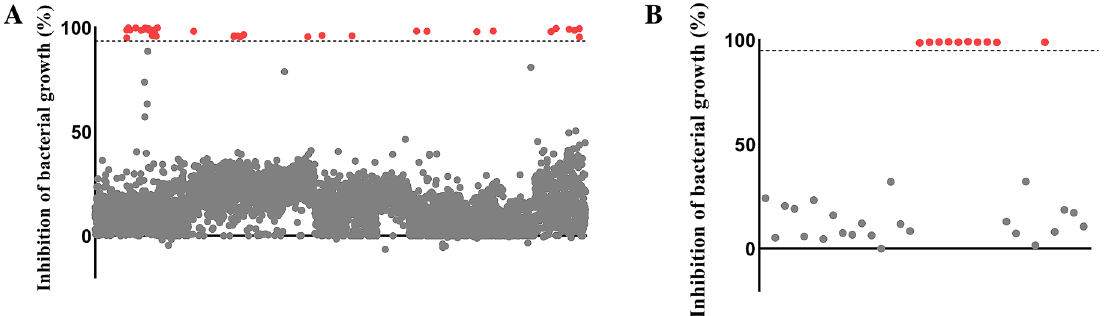
Figure 1. High-through screening (HTS) of the AnalytiCon NATx library identifies novel lead scaffolds. ( A ) Results from HTS of 5000 natural product-like compounds from the AnalytiCon NATx library. Compounds were screened at a concentration of 3 µM against C. difficile ATCC BAA 1870. Compounds exhibiting greater than 95% inhibition of bacterial growth were deemed to be hits. 34 hits were obtained from the initial screening of the library. ( B ) Plate cherry-picking of the 34 hits obtained from the initial screening revealed a final count of 10 hits against C. difficile ATCC BAA 1870 at a concentration of 3